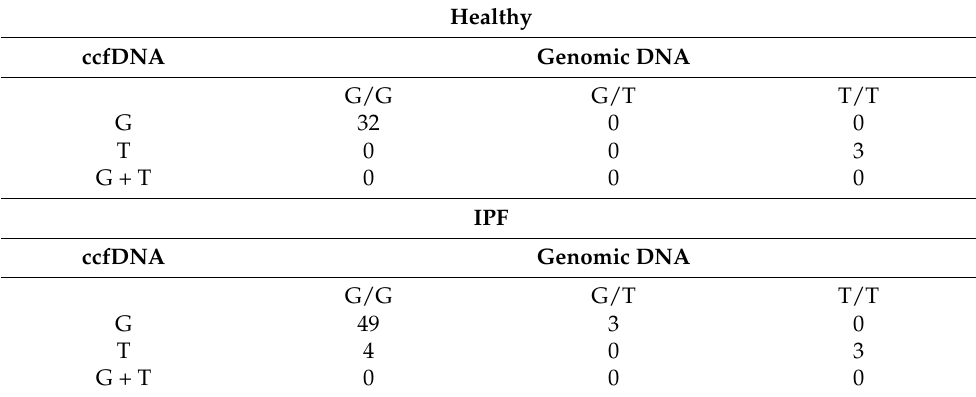
Table 3. Distribution of the rs35705950 MUC5B polymorphism in circulating cell-free DNA and genomic DNA for comparison in healthy and IPF patients.